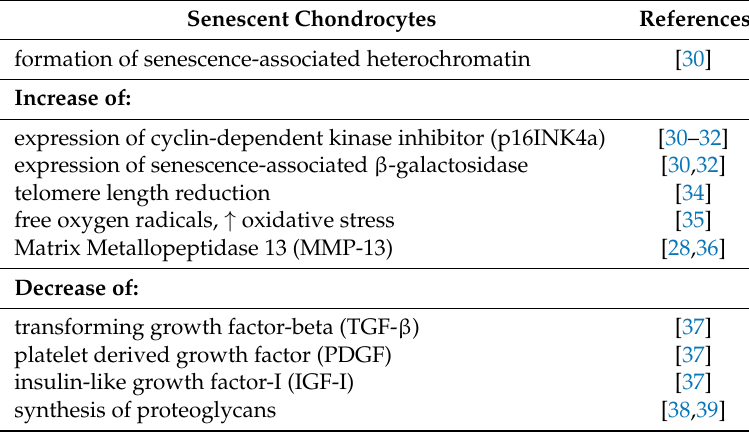
Table 1. Characteristics of